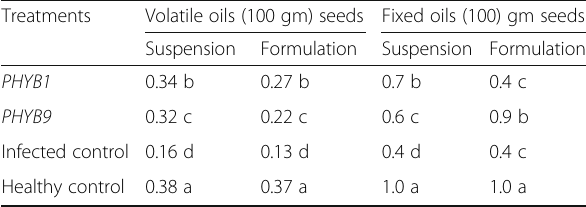
Table 4 Effect of Bacillus simplex as suspension and/or formulation on volatile oils and fixed oils